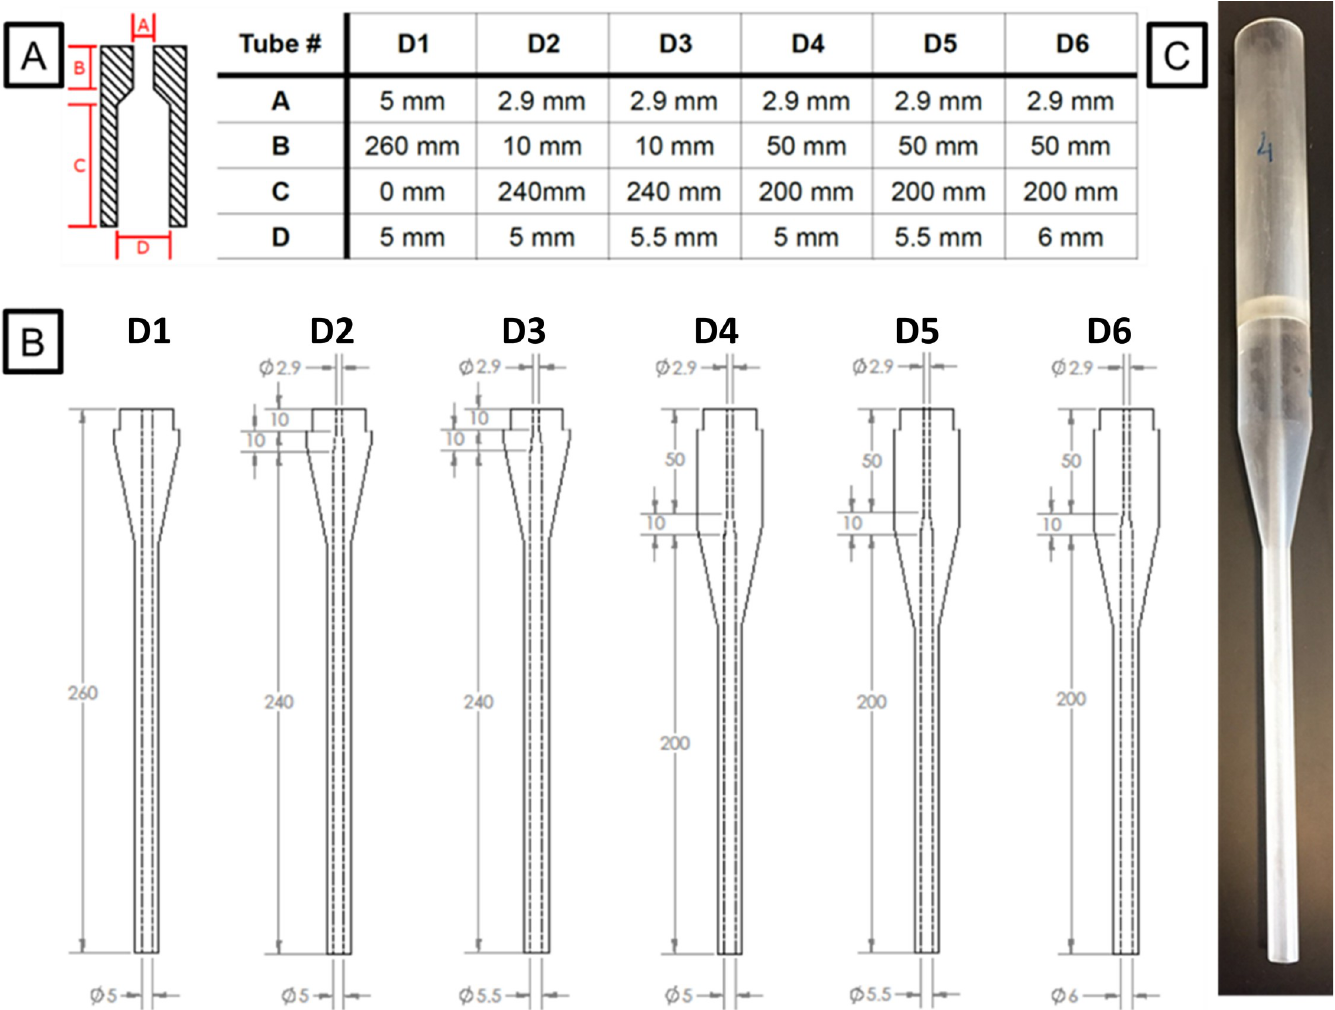
Fig 2. Computer aided and 3D printed designs. (A) Shows the critical design parameters of the designs chosen. A: inlet tube diameter, B: length of the connector, C: length of the surrogate G-tube devices from where the connector ends to the distal end, D: outlet tube diameter. (B) SolidWorks designs of the six surrogate designs showing the internal passageways. All dimensions are in mm. (C) 3D printed D4 syringe-design combination is shown (not to